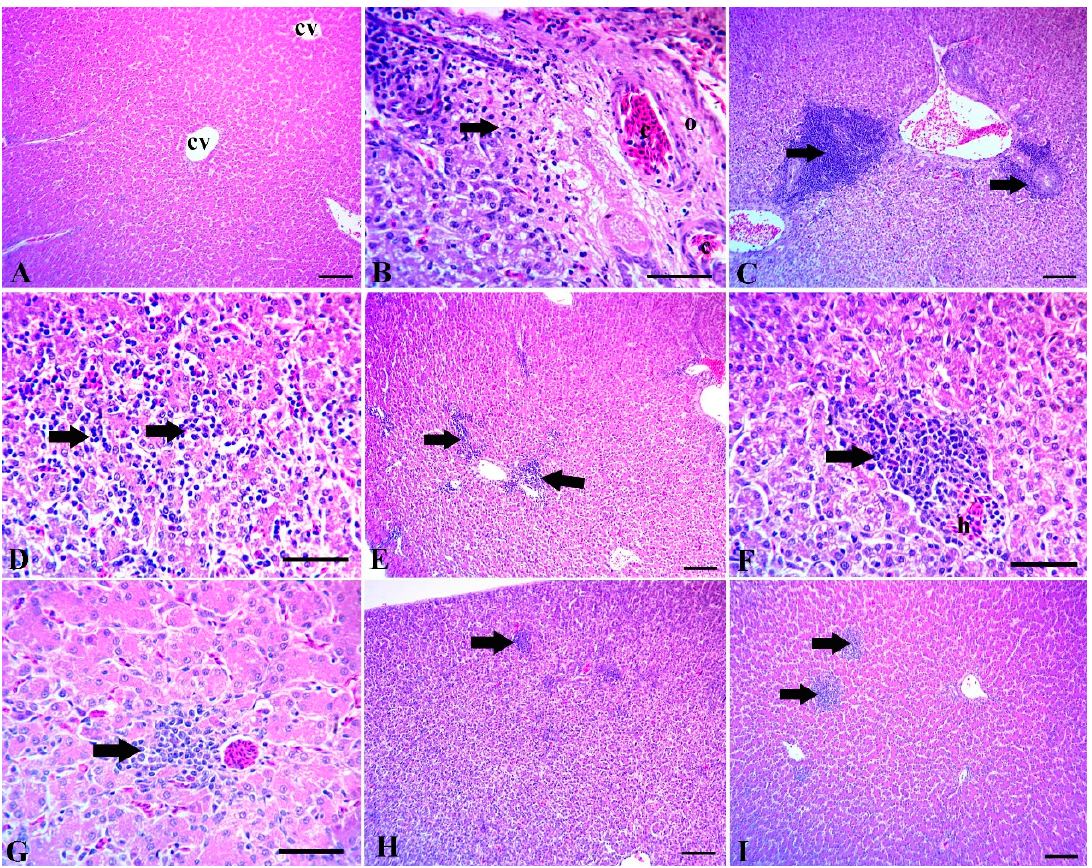
Figure 1. ( A ) Liver of control group without Clostridium challenge, showing normal tissue architecture, Figure 1. (A) Liver of control group without Clostridium challenge, showing normal tissue normal hepatic lobules, a normal central vein (cv) and hepatic sinusoids. ( B–D ) The intestine of chicks architecture, normal hepatic lobules, a normal central vein (cv) and hepatic sinusoids. (B, C, D) The after the Clostridium challenge. ( B ) Congestion of portal blood vessels (c) with perivascular edema intestine of chicks after the Clostridium challenge. (B) Congestion of portal blood vessels (c) with (o) and coagulative necrosis of the surrounding hepatocytes (arrow). ( C ) Numerous lymphocytic perivascular edema (o) and coagulative necrosis of the surrounding hepatocytes (arrow). (C ) aggregations around the congested portal blood vessels. ( D ) Extensive lymphocytic aggregations Numerous lymphocytic aggregations around the congested portal blood vessels. (D) Extensive among the hepatocytes (arrows). ( E–I ) Liver of chicks challenged with Clostridium and supplemented lymphocytic aggregations among the hepatocytes (arrows). (E, F, G, H, I) Liver of chicks challenged with: ( E ) Maxus, showing moderate scattered lymphocytic aggregations (arrows); ( F ) Clostat, showing with Clostridium and supplemented with: (E ) Maxus, showing moderate scattered lymphocytic mild hemorrhage and ( H ) focal aggregation of lymphocytes (arrow); ( G ) Sangrovit, showing mild aggregations (arrows); (F) Clostat, showing mild hemorrhage and (H) focal aggregation of perivascular lymphocytic aggregation (arrow); (H) Clostat + Sangrovit, showing mostly normal hepatic lymphocytes (arrow); (G) Sangrovit, showing mild perivascular lymphocytic aggregation (arrow); tissue, except for minute focal lymphocytic aggregations (arrow); ( I ) Gallipro, showing moderate focal (H) Clostat + Sangrovit, showing mostly normal hepatic tissue, except for minute focal lymphocytic lymphocytic aggregations. Scale bar = 100 µ m ( A,C,E,H,I ) and 50 µ m ( B,D,F,G aggregations (arrow); (I) Gallipro, showing moderate focal lymphocytic aggregations. Scale bar = 100 µm (A, C, E, H, I) and 50 µm (B, D, F, G).